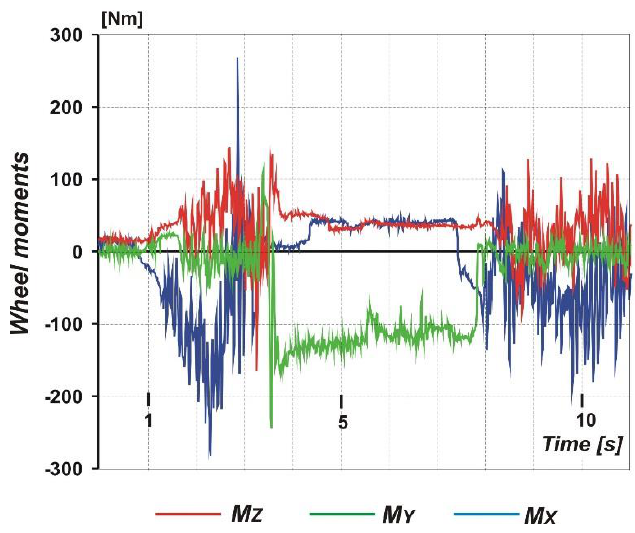
Figure 10. Sample result of the measurements: Time courses of three moments acting on the landing gear wheel.